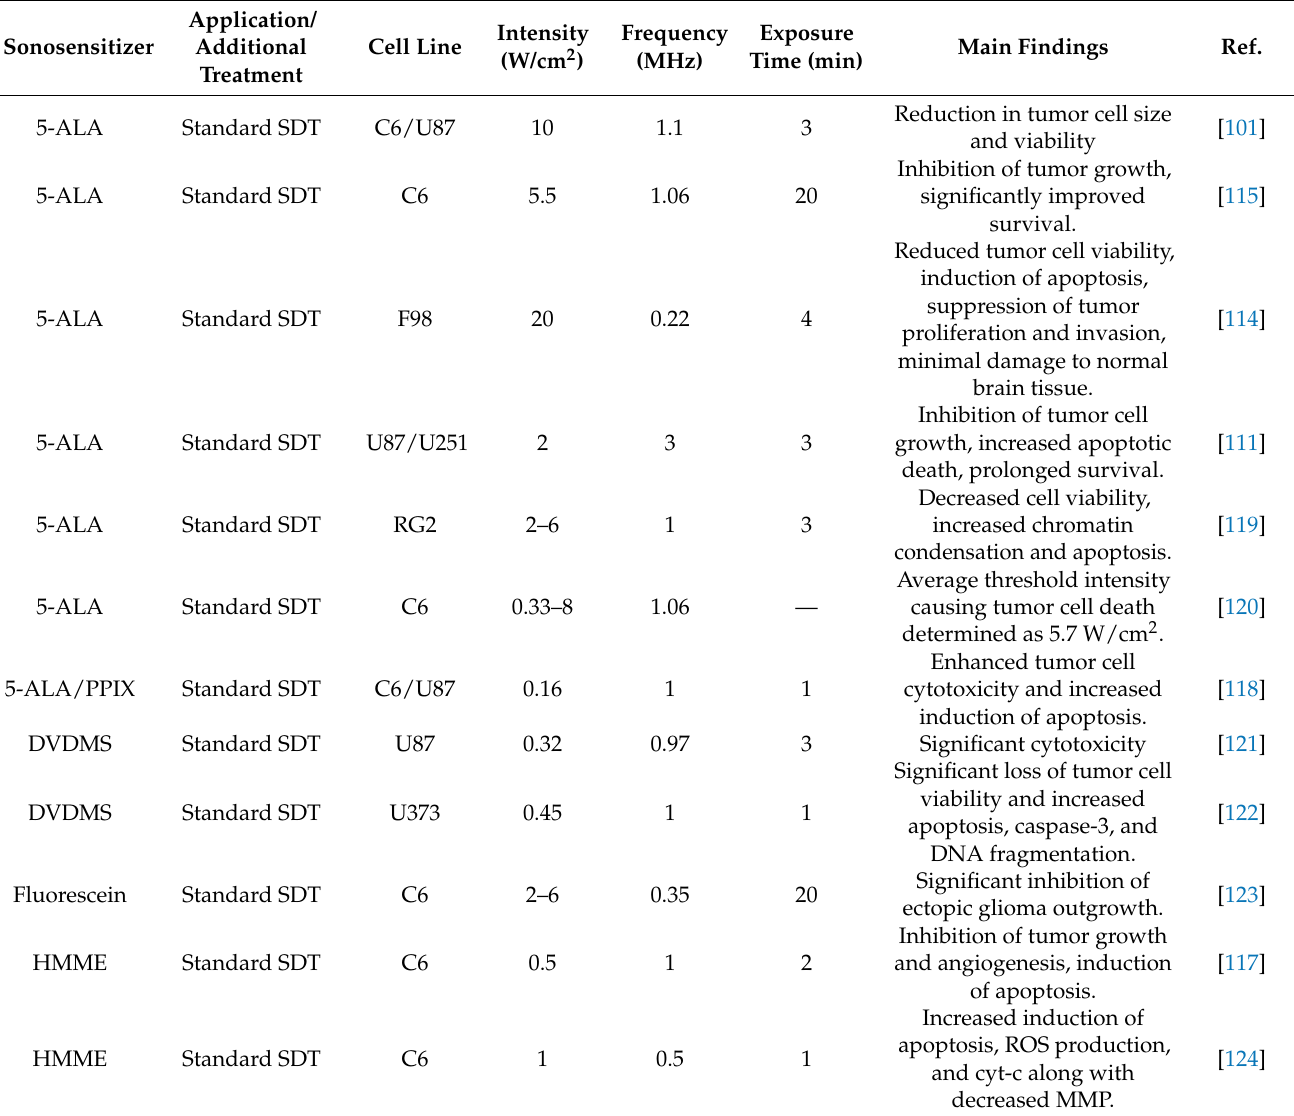
Table 1. Preclinical investigations into SDT for treatment of